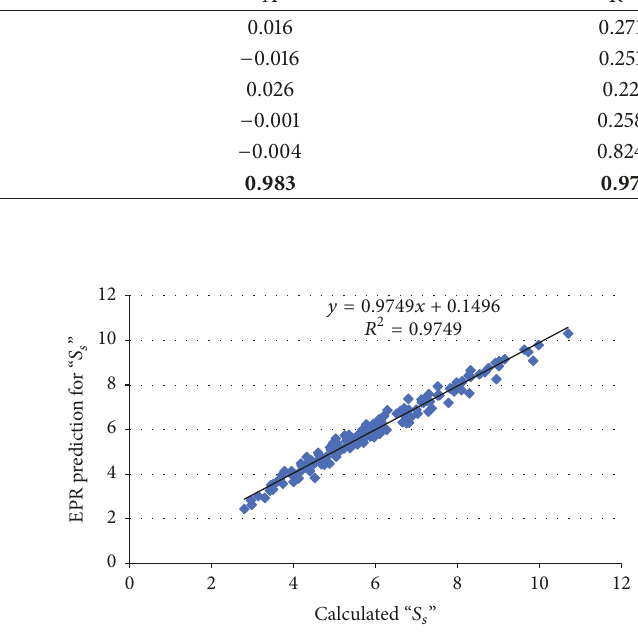
Figure 22: The calculated values of static settlement versus its corresponding EPR prediction.